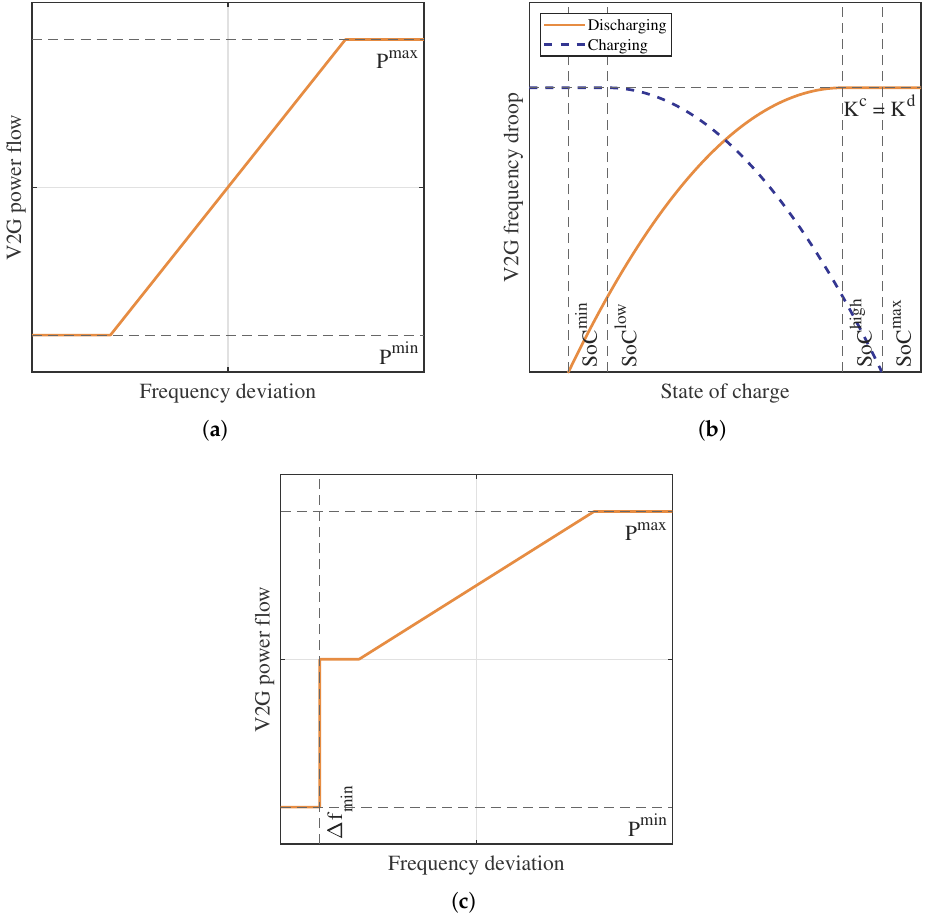
Figure 4. ( a ) ElCo: V2G power flow control scheme. ( b ) BaCo: V2G frequency droop as a function of the SoC for the charging and discharging cases (the SoC is kept around 0.5 by using SoC max = 0.8 and SoC low = 0.2 [32]). ( c ) SmChCo: V2G power flow control scheme = 0.1, SoC high SoC min i i i